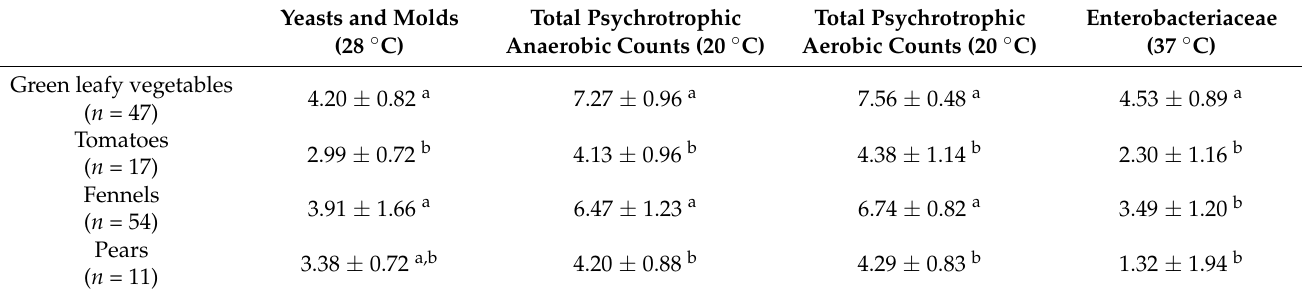
Table 1. Microbial loads (log CFU/g) of yeasts and molds, total psychrotrophic anaerobic and aerobic populations, Enterobacteriaceae . The values shown are the mean value of all the samples analyzed for each product type ( ± standard deviation). Different letters in column indicate significantly different values between the different product types, as determined by paired t -tests ( p <